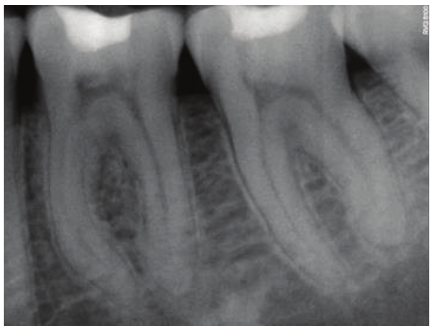
Figure 21: 9-month followup RVG: 36,